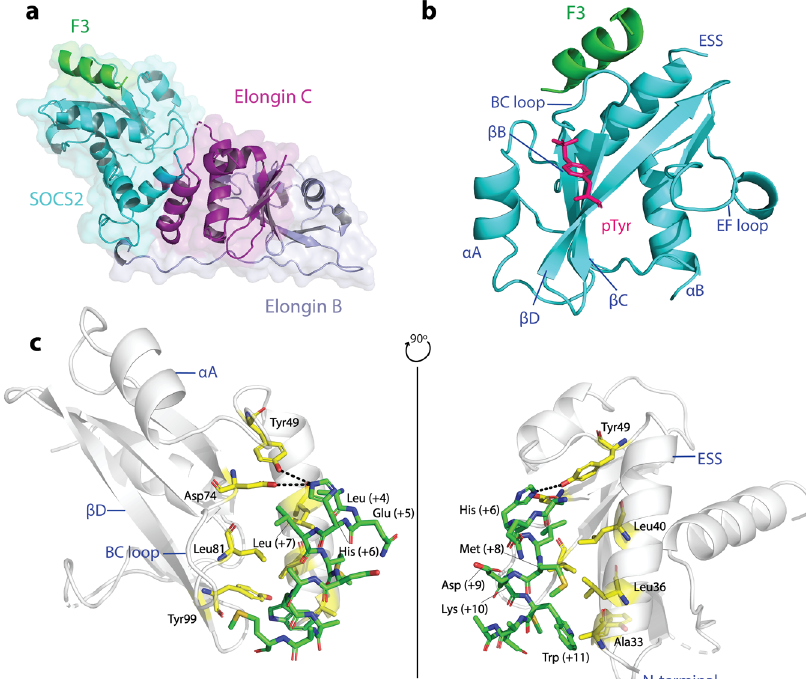
Fig. 3 The crystal structure of F3 in complex with SOCS2, reveals F3 as an α -helix bound to a site distal from the pTyr-binding pocket. a Cartoon and surface representation of the F3 (green)/SOCS2 (cyan)/Elongin B (light blue-purple)/Elongin C (magenta) 3.1 Å crystal structure. b Notably, F3 binds as an α -helix on the opposite side to the pTyr-binding pocket, cradled between the ESS and phosphotyrosine binding loop. c Ribbon diagram of the SOCS2- SH2 (white) and F3 structure showing the detailed side-chain interactions. The SOCS2-ESS and canonical SH2 domain make multiple contacts with the F3 peptide. Seven key residues within the SOCS2-ESS, the loop connecting ESS and α -helix A, the BC loop, and β -strand D, make key contacts with F3 residues and are highlighted in yellow. Dashed lines indicated polar interactions between F3 (His6) and residues on SOCS2 F3 peptide: carbon = green; oxygen = red; nitrogen = blue. Figures were generated using The PyMOL Molecular Graphics System, Version 2.0 Schrödinger,